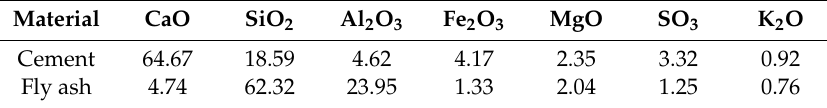
Table 2. Chemical compositions (mass percentages of oxides,